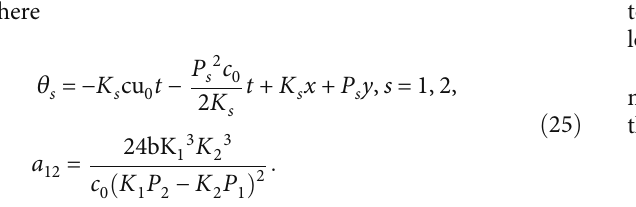
Figure 2: Two types of lump solutions in Equation (1) with parameter c Bright-type lump solution with u 0 = 1 and c = − 1 . (b) Dark-type lump solution with u 0 = − 1 and c = 1